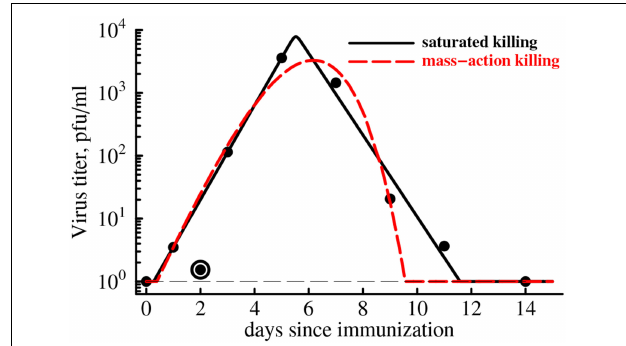
FIGURE 4 | CD8 T cell expansion kinetics explain clearance of yellow fever virus. We use parameter estimates for an “average” individual (last row in Table 1 ) to predict the kinetics of clearance of YFV in the blood with a simple mathematical model (Equation 4). Data are shown as points. Two types of model fits to data are shown: (1) model in which killing of the virus population follows the law of mass-action ( h = 0, n = 1, dashed line), and (2) model in which killing of the virus population is saturated at high CD8 T cell densities ( h > 0, n = 50). We find that the best fit is provided by the model in which killing of virus-infected cells saturates at high density of YFV-specific CD8 T cells even though this improvement in the fit is not statistically significant due to a low number of data points ( F 1 , 4 = 4 . 94, p = 0 . 09). Parameter providing the best fit are V 0 = 0 . 43, r = 2 . 39 day − 1 , k = 24 . 4 day − 1 , h = 0, n = 1 (for the mass-action killing model) and V 0 = 0 . 63, r = 1 . 73 day − 1 , k = 13 . 3 day − 1 , h = 13 . 0, n = 50 (for the saturated killing model). Data point at day 2 was excluded in model fits to the data as an outlier. Hill coefficient was fixed in model fits of the data. The virus detection limit in these experiments was 1PFU/ml and is shown by a thin dashed